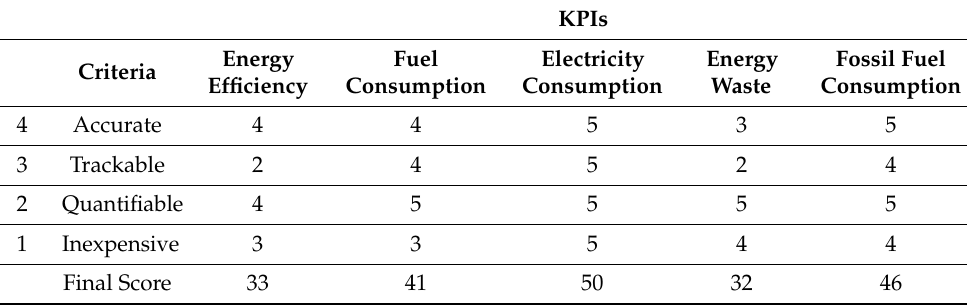
Table 4. Case study result of company A—target: reduce energy